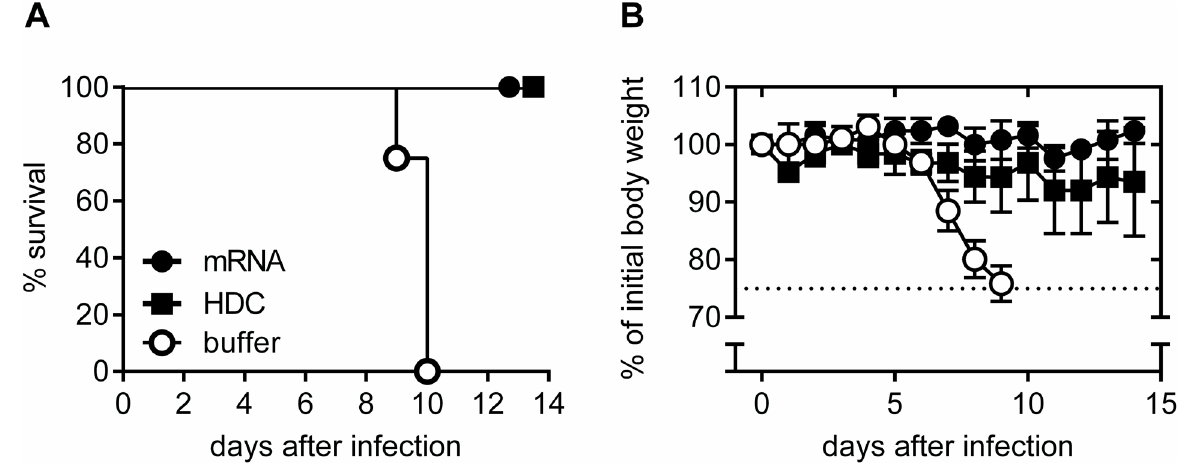
Fig 3. Protective capacity of mRNA vaccine against lethal intracerebal (i.c.) rabies challenge infection. Female BALB/c mice were vaccinated twice (days 0 and 21) with 80 μ g RABV-G mRNA, 0.1 human dose HDC or injection buffer alone as negative control. Six weeks after the second immunization, mice were infected i.c. with rabies virus. (A) Survival of challenged mice is illustrated by a Kaplan-Meyer-analysis. (B) Body weight of challenged mice was monitored daily. As soon as animals lost 25% of initial body weight (dotted line), animals were sacrificed for reasons of humane endpoint criteria (n = 5 /group). Mean and SD is